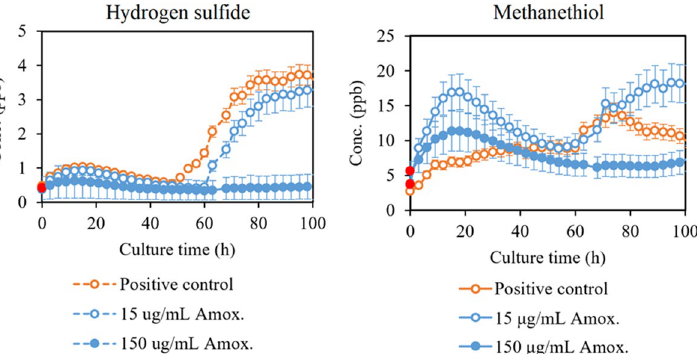
Figure 3. Hydrogen sulfide and methanethiol produced by P. gingivalis untreated (positive control) and treated with amoxicillin. The time of antibiotic addition is marked in red. Concentrations are given as the mean ± SD of triplicate measurements (N = 3).